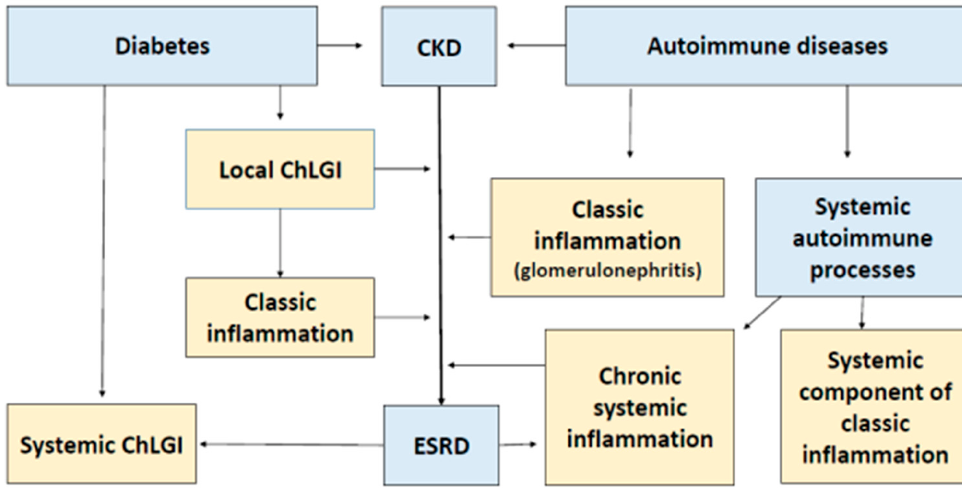
Figure 3. Relationship among the root causes of chronic kidney disease (CKD), end-stage renal disease (ESRD), and general pathological processes. On the left side of the scheme, diabetes mellitus and hypertension (against the background of obesity and metabolic syndrome) contribute to the emergence of a systemic proinflammatory status of the chronic low-grade inflammation (ChLGI) type. Simultaneously, pronounced local manifestations of ChLGI contribute to the development of CKD. In DKD, ChLGI is frequently transformed into alterations that resemble the classical variants of inflammation. These processes also lead to ESRD. ESRD, in turn, is an obvious inducer of changes in the proinflammatory status of the body according to the variant of chronic systemic inflammation (ChSI). On the right side of the diagram, many autoimmune diseases are associated with primary and secondary chronic glomerulonephritis, characterized by fibrinous productive variants of canonical inflammation and CKD, which can progress to ESRD. In some systemic autoimmune diseases, especially in systemic lupus erythematosus, secondary manifestations of chronic glomerulonephritis and primary (before ESRD) development of ChSI are noted, which additionally contribute to the progression of CKD to ESRD with the formation of a vicious pathogenetic cycle.